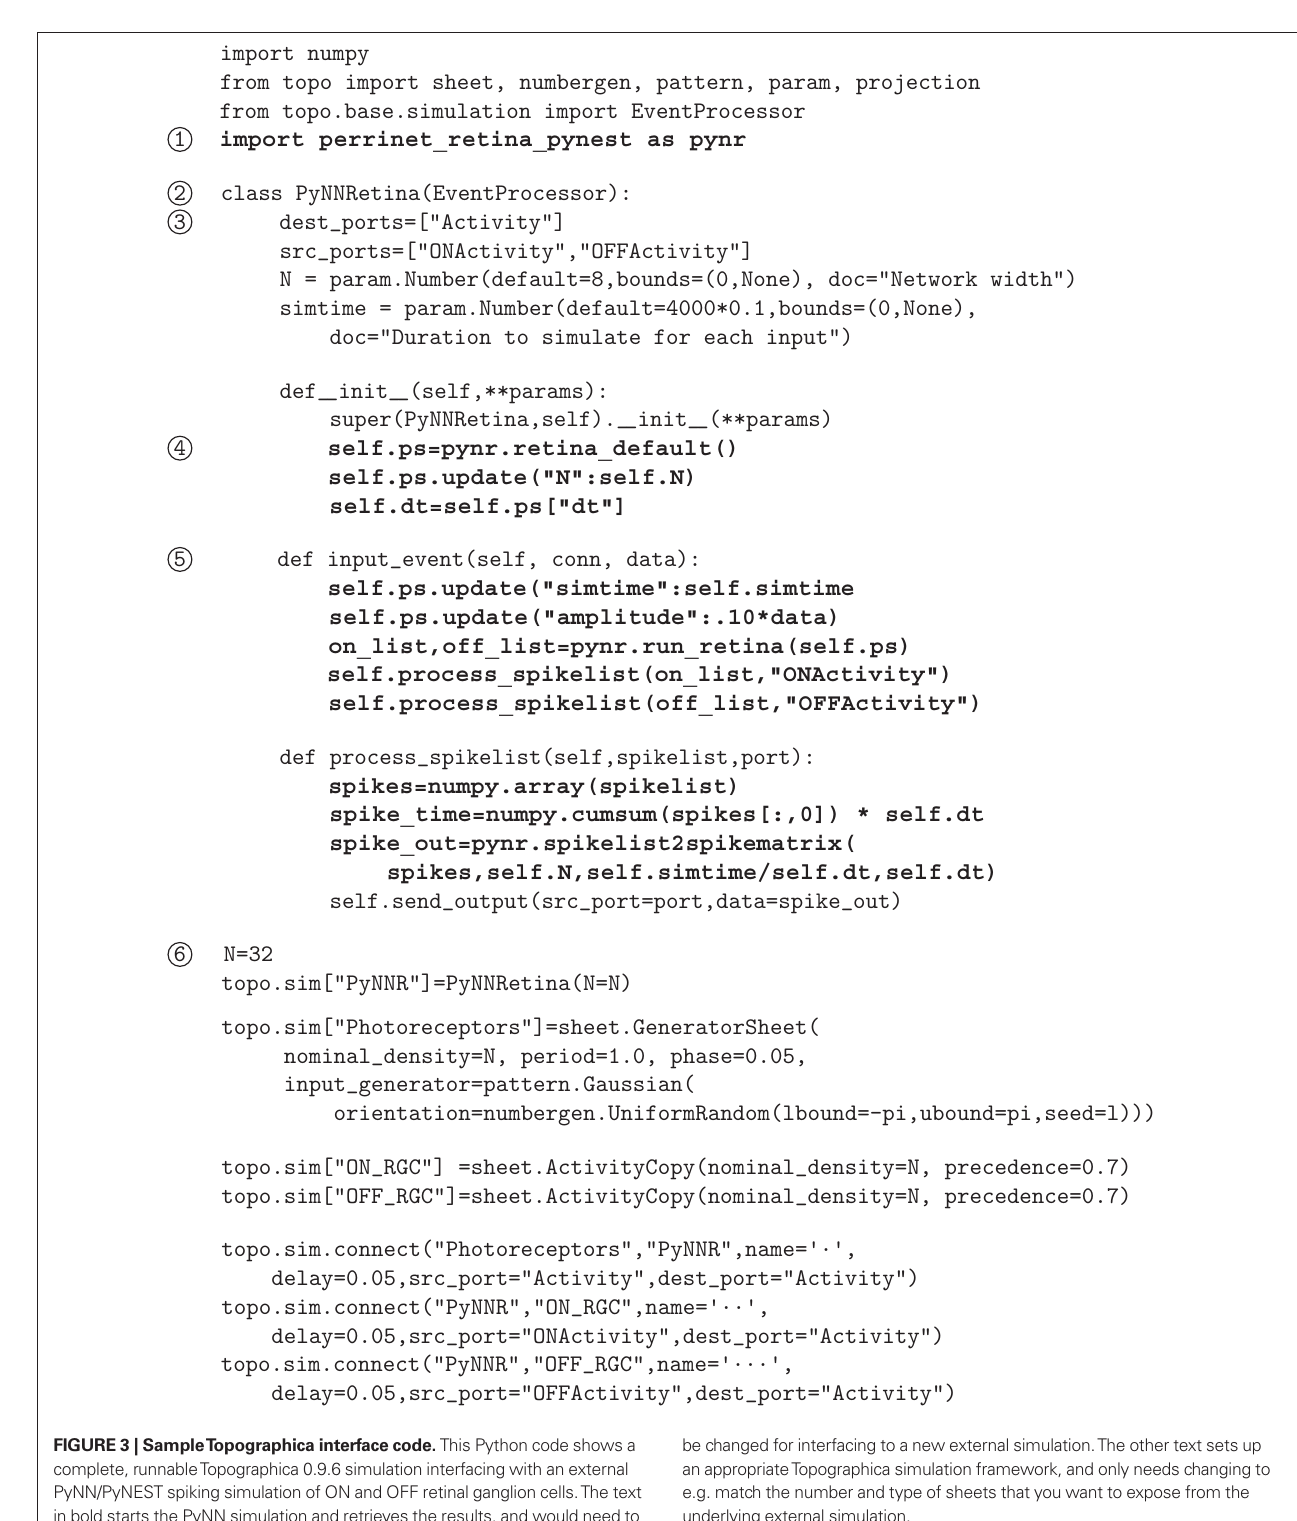
FIGURE 3 | Sample Topographica interface code. This Python code shows a complete, runnable Topographica 0.9.6 simulation interfacing with an external PyNN/PyNEST spiking simulation of ON and OFF retinal ganglion cells. The text in bold starts the PyNN simulation and retrieves the results, and would need to